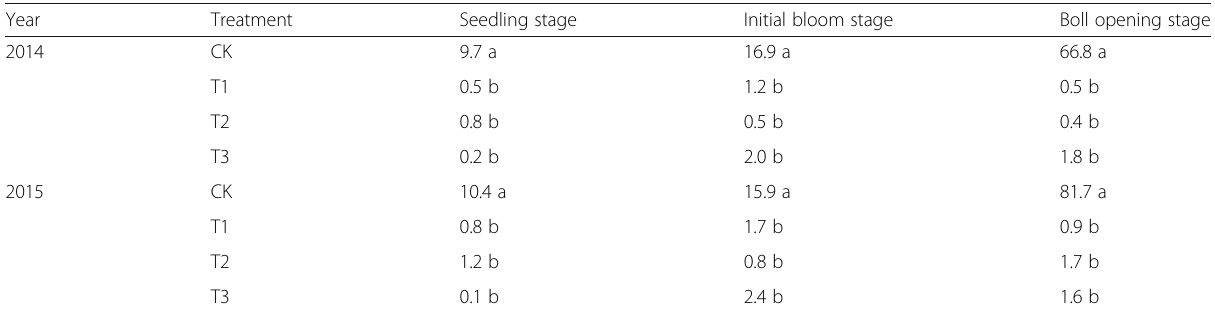
Table 6 Changes in weeds weight at different cotton growth stages in different treatments in 2014 and 2015 (g·m − 2 ) Year